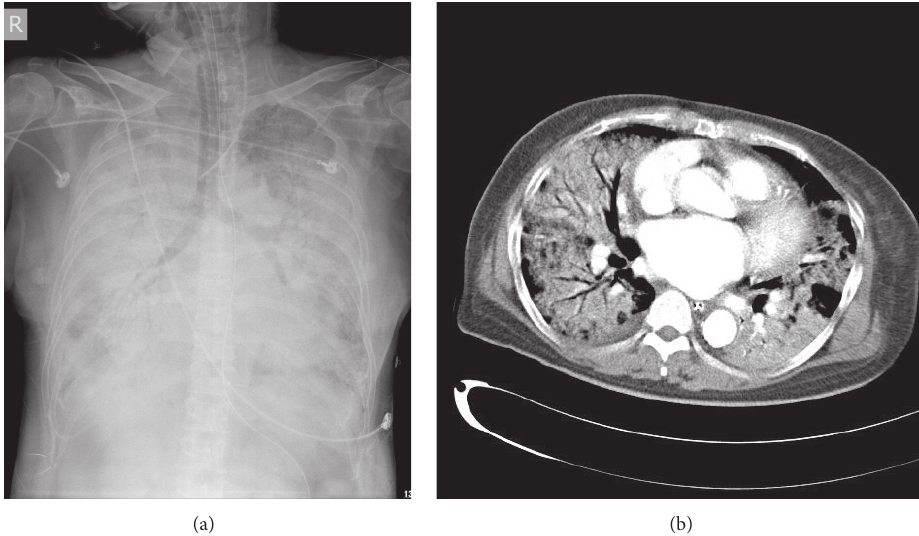
Figure 2: (a) A second chest X-ray showed bilateral consolidation with a snowflake pattern (8 h upon admission). (b) Chest computed tomography of the lungs demonstrated diffuse bilateral alveolar and interstitial infiltrations with a presentation compatible with acute respiratory distress syndrome